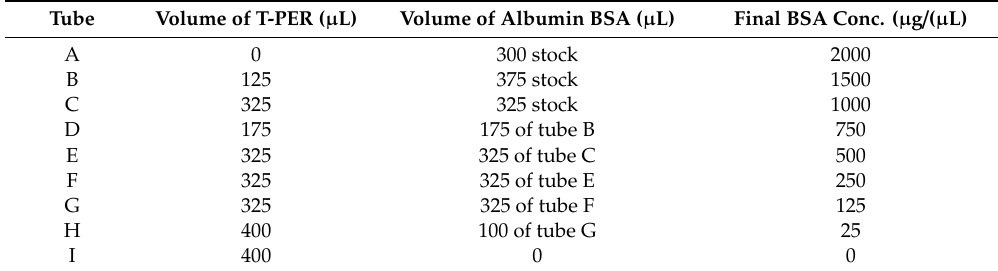
Table 9. Preparation of albumin standards for the BCA